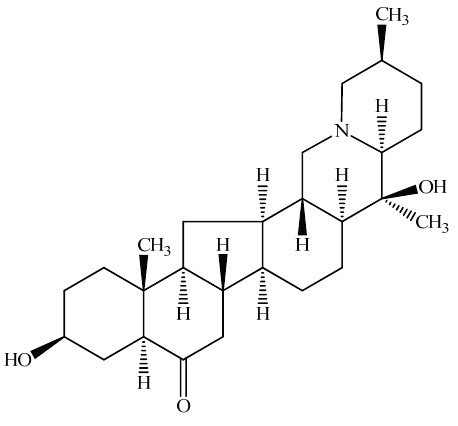
Figure 1. Chemical structure of